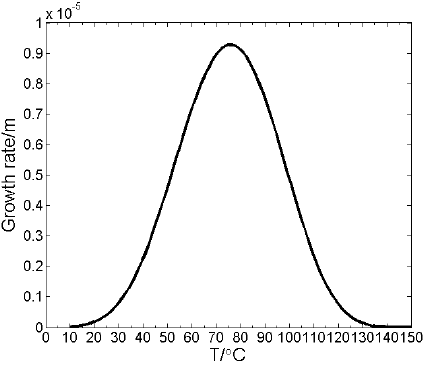
Figure 11. Growth rate versus temperature.